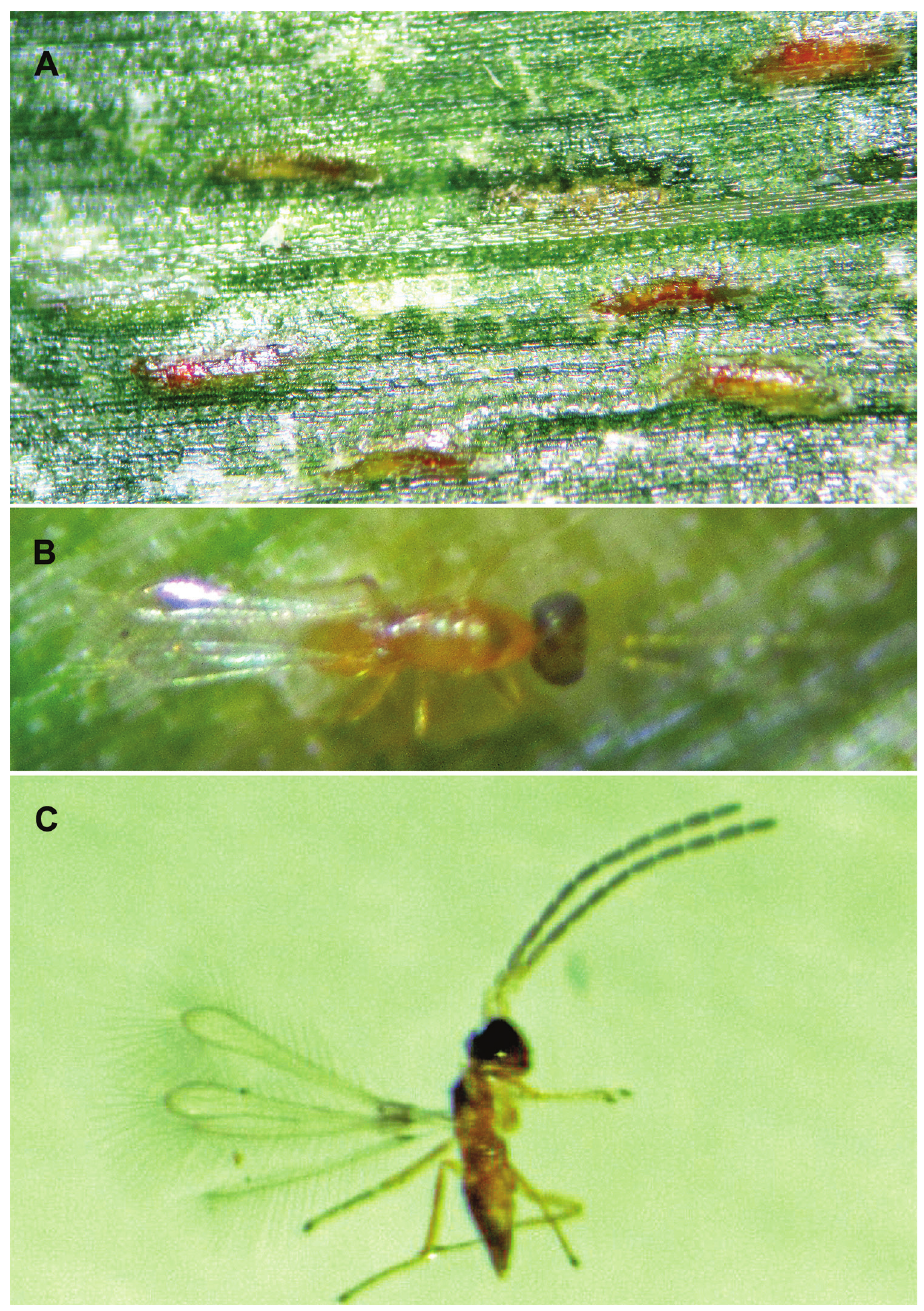
Figure 4. A parasitized eggs of Zyginidia eremita by Anagrus dmitrievi in a maize leaf B an adult female of A. dmitrievi right after emergence C an adult male of A. dmitrievi